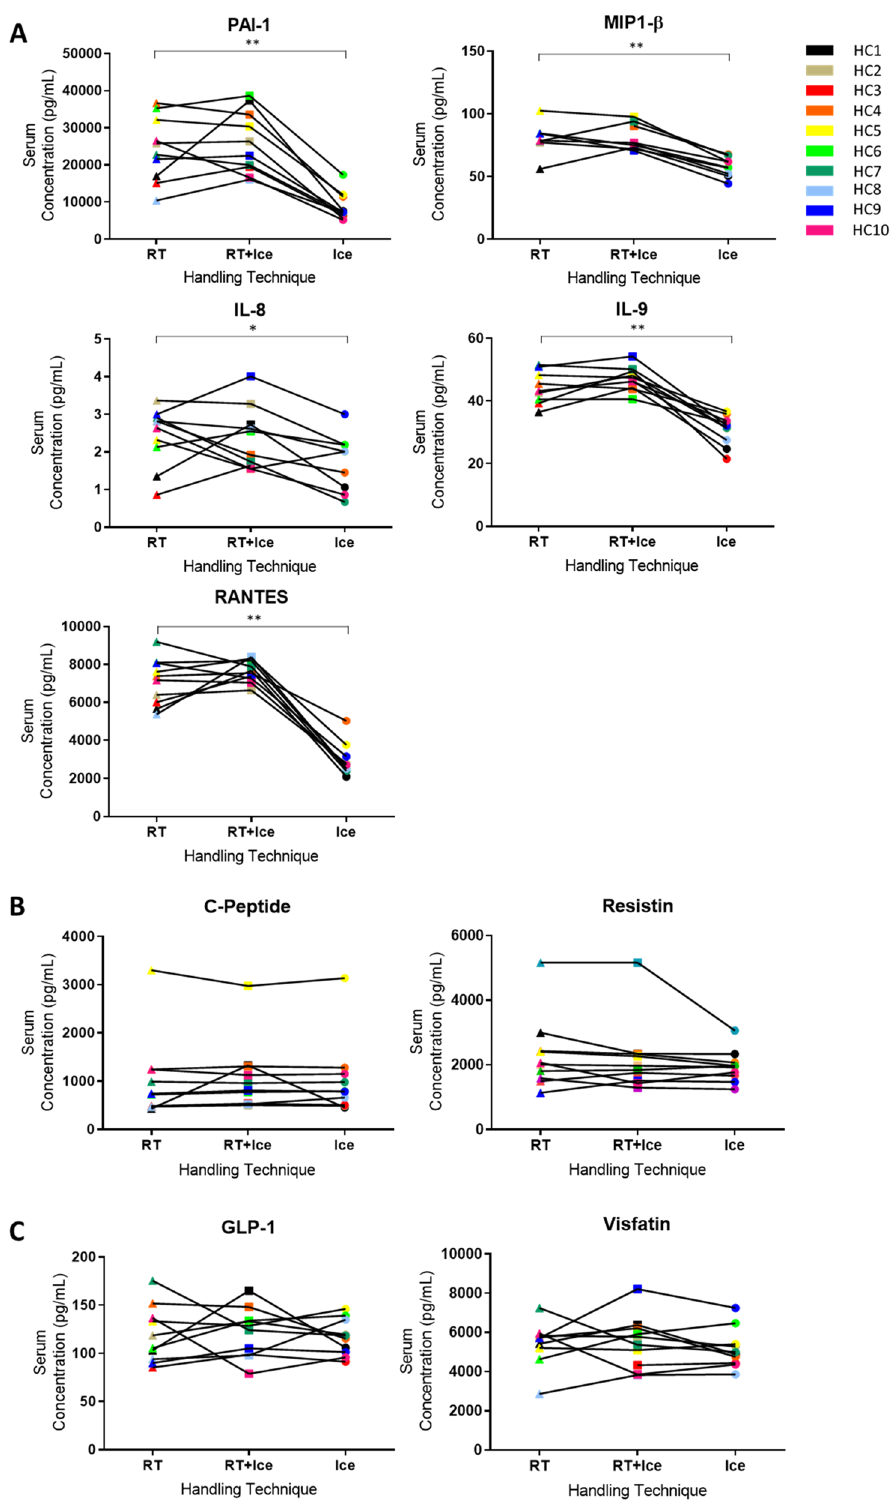
Figure 1. The effects of alternative pre-processing protocols on serum analyte levels. The serum levels of selected analytes in healthy control samples following three pre-processing protocols are shown. The reference protocol, 1 h at room temperature (RT) and two alternative protocols, 1 h at RT followed by a further 3 h on ice (RT + Ice) or 1 h on ice (Ice) were compared. ( A ) Significant differences were identified in the levels of PAI-1, MIP1-B, IL-9, RANTES and IL-8 levels. ( B ) Some analytes demonstrated minimal changes. ( C ) While no statistically significant differences are observed for some analytes, specific individual samples undergo considerable changes in response to handling variables. Paired t-tests were performed to examine for significant differences between mean analyte levels in samples from reference and alternative protocols. * represents p ≤ 0.05, ** represents p <